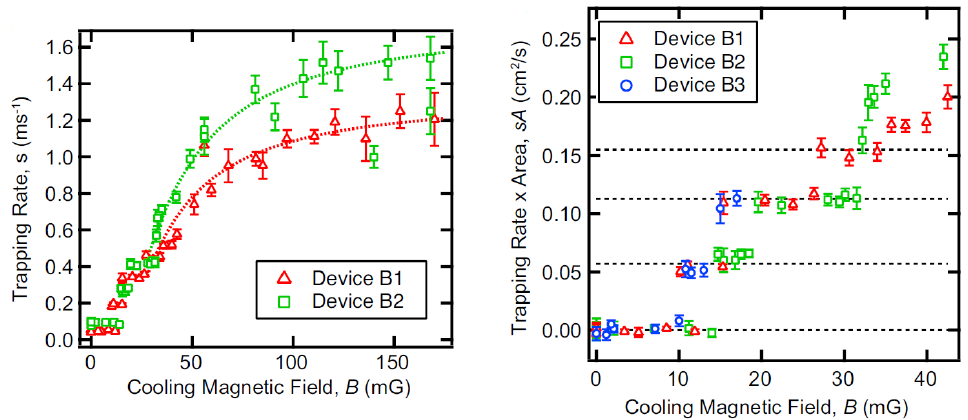
Figure 9: (adapted from Ref. [ 30 ] ) Left: quasiparticle density decay rate (or trapping rate) vs cooling field for two devices . Right: trapping rate times area vs field for three devices; at low field, the stepwise increase of the rate is